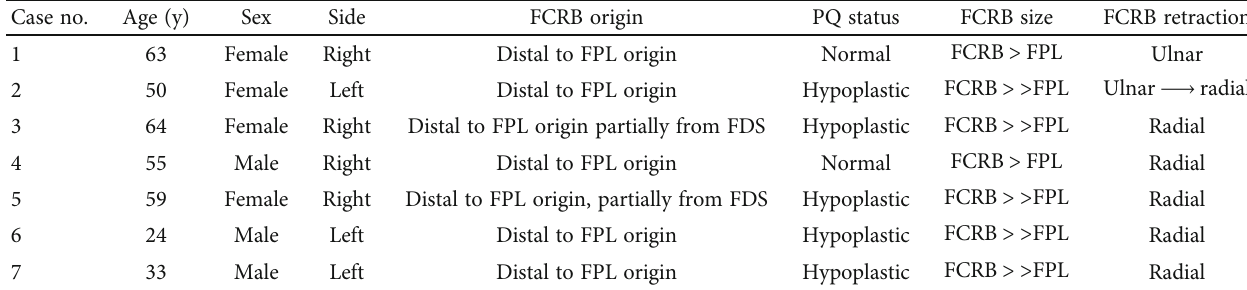
Table 1: Clinical data of the seven patients with FCRB.